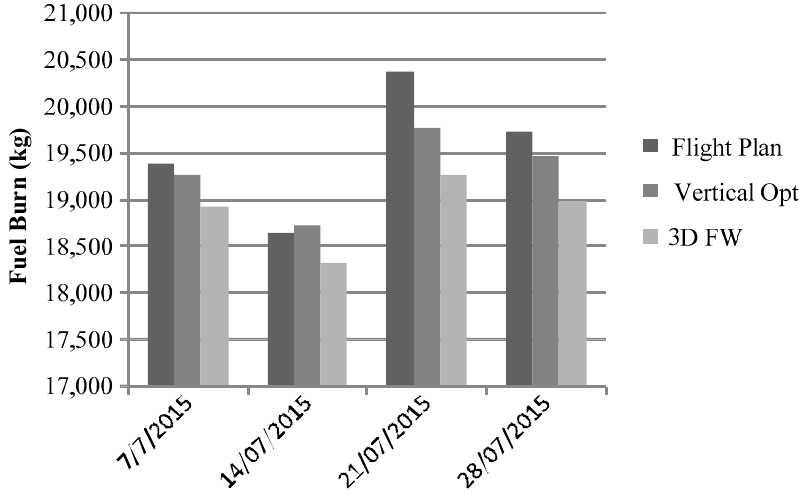
Figure 11. Fuel burn differences between reference flight, optimized vertical flight, and optimized 3D Floyd–Warshall (FW) flight trajectories.